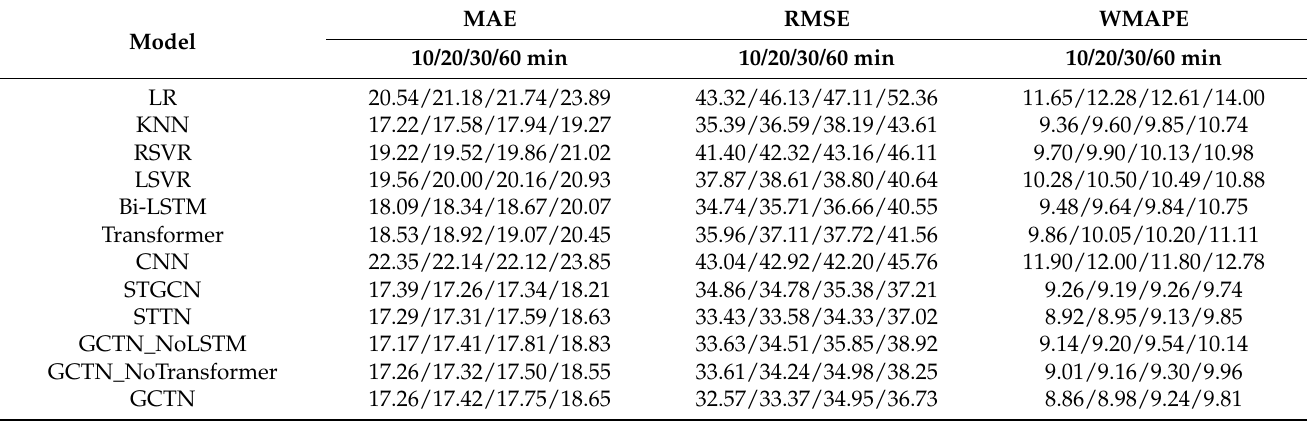
Table 3. Evaluation results of different models and TIs (10 min).